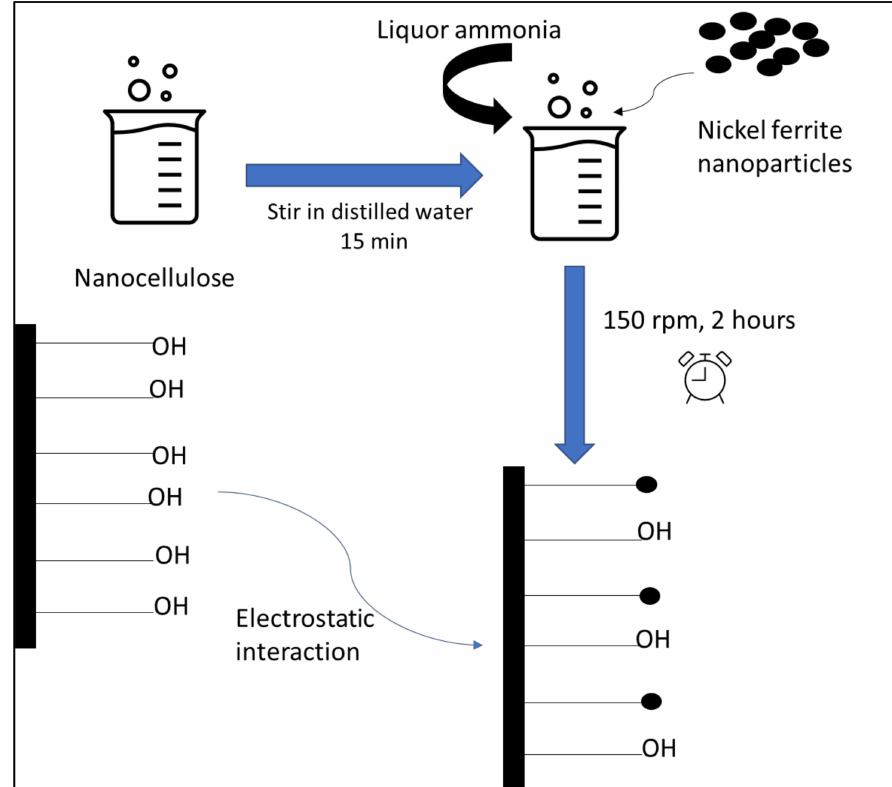
Figure 3. Schematic diagram of preparation